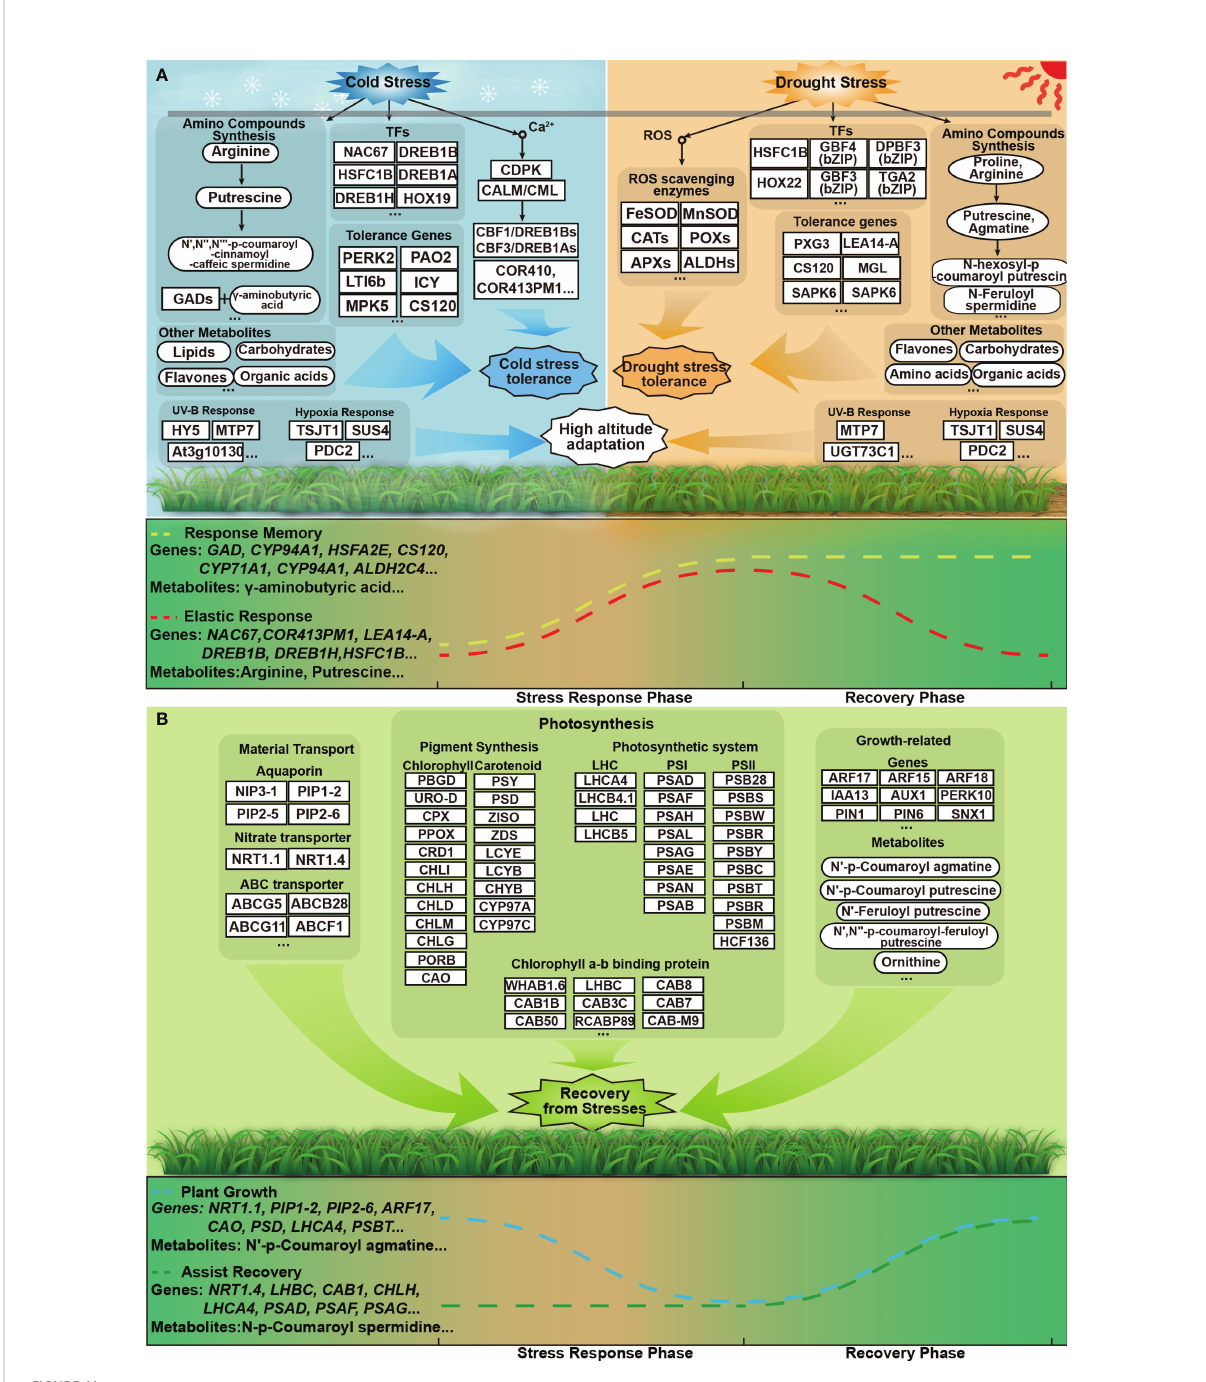
FIGURE 11 Flexible answer and quick recovery models of P. crymophila under cold and drought stresses. (A) The stress-adaptive strategies of the induced genes and metabolites. In the stress stage, a large number of response genes are rapidly expressed. Most of these genes and metabolites can be recovered from stress, and some of them are dif fi cult to recover. (B) The stress-adaptive strategies of the repressed and unchanged genes and metabolites under adversity. These genes and metabolites involved in material transport, photosynthesis, and plant growth can rapidly restore or improve after stress